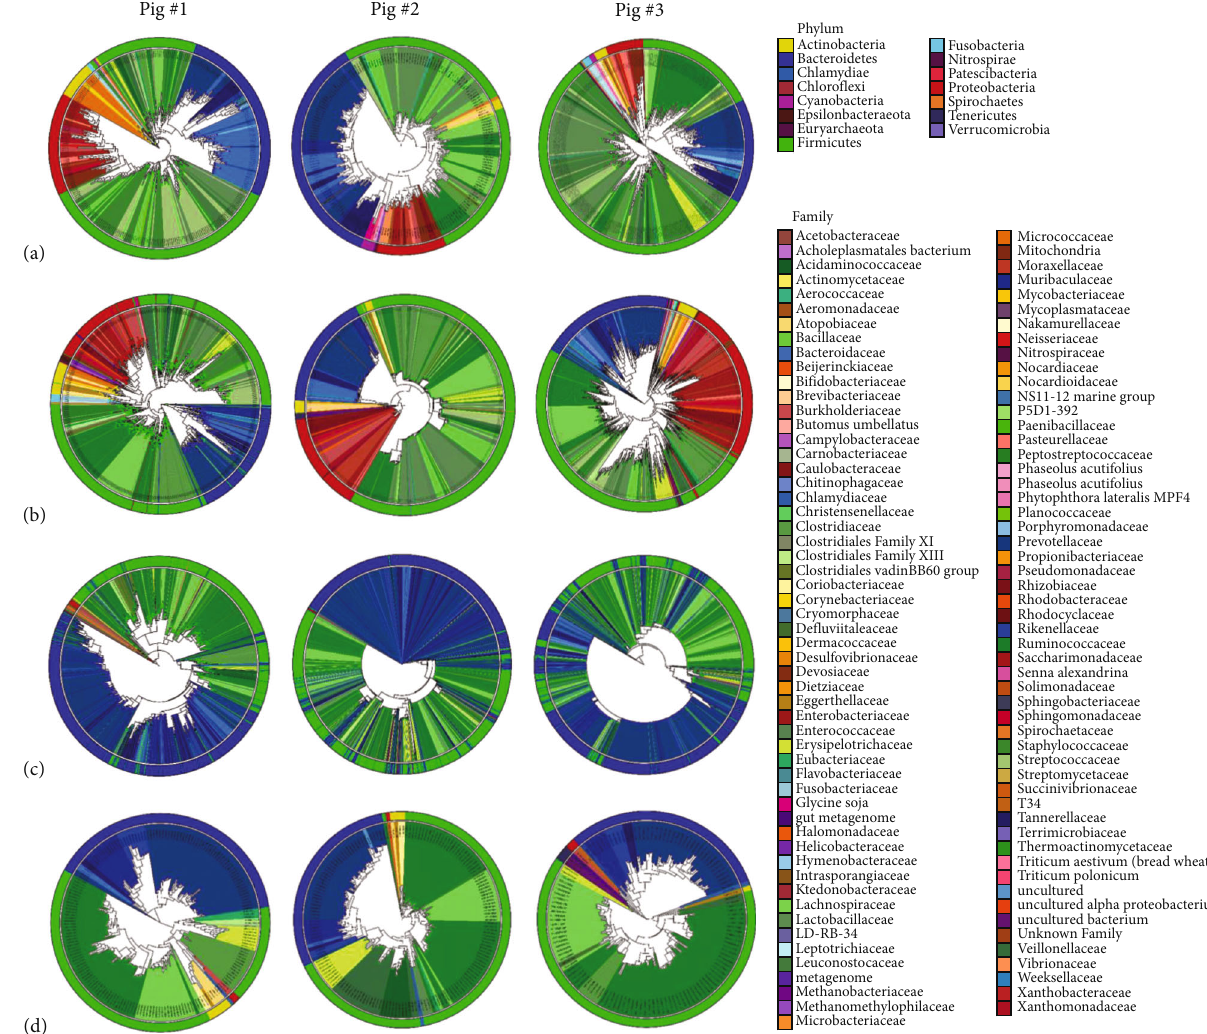
Figure 2: Maximum-likelihood phylogenetic tree comprising of the taxa at the stomach (a), the small intestine (b), and the large intestine (c) of the GI tract and feces (d) of pigs #1 ~ 3. Clades are labeled according to the species. Phylum is depicted in the fi rst outer layer and brunch node. Inner circle color represents the family